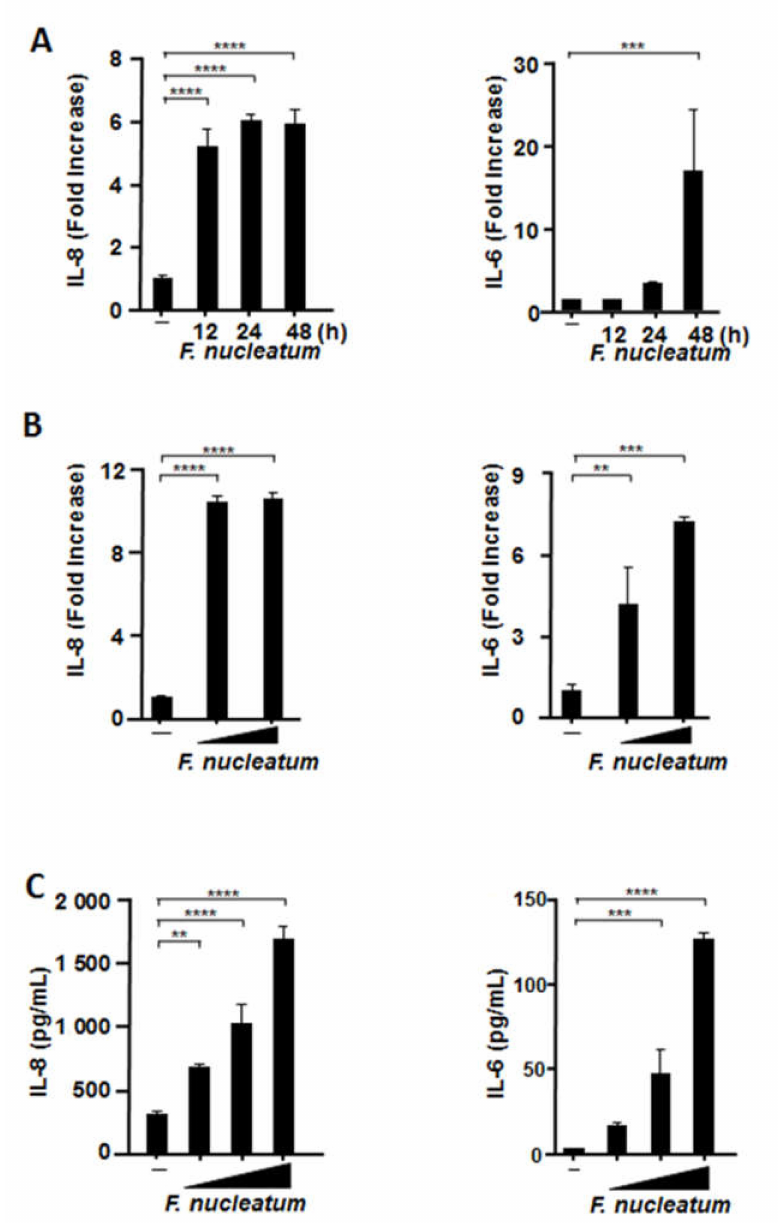
Figure 2. CSF induces the mRNA expression and protein production of proinflammatory cytokines in human alveolar epithelial cells. A549 cells were exposed to CSF (100 µ L/mL) for the indicated times ( A ) or at different concentrations (50 or 100 µ L/mL) for 48 h ( B ). The cells were harvested, and interleukin ( IL ) -8 and IL-6 mRNA levels were measured by RT-qPCR. The mRNA levels were normalized to those of glyceraldehyde-3-phosphate dehydrogenase and expressed as fold increases. ( C ) A549 cells were exposed to CSF (25, 50, or 100 µ L/mL) for 48 h. IL-8 and IL-6 protein levels were ascertained by means of enzyme-linked immunosorbent assay and expressed as pg/mL. These ex- periments were performed in triplicate, and data are presented as the mean ± SD; n = 3 (**, p < 0.01; ***, p < 0.005; ****, p <